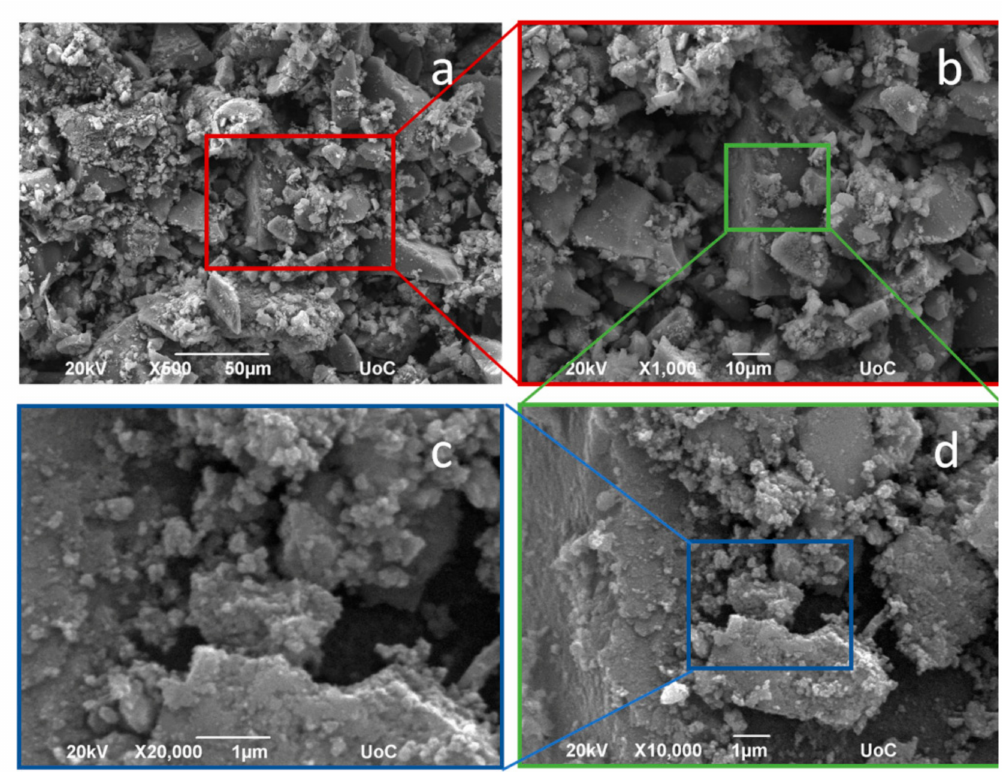
Figure 5. SEM images of TiO 2 enriched with C-dots: ( a ) image captured from random area; ( b – d ) magnified images of the area selected at ( a ).